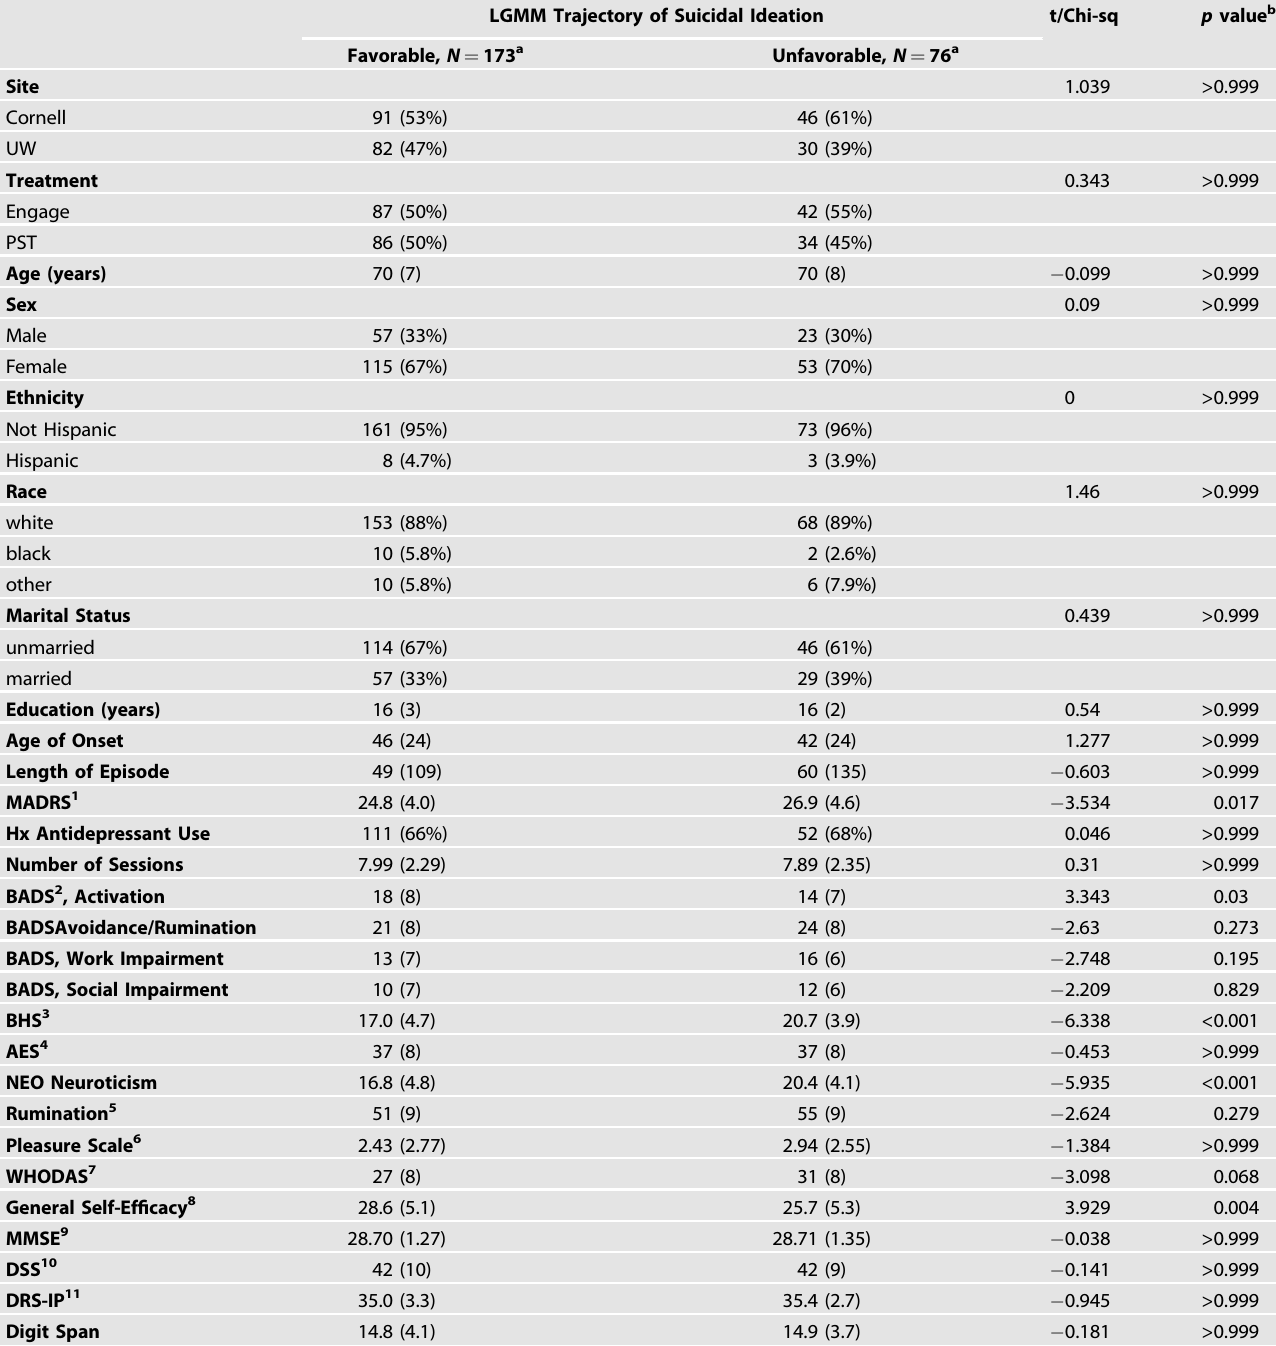
Table 1. Baseline clinical and demographic characteristics of members to two suicidal ideation trajectories identi fi ed by Latent Growth Mixture Model